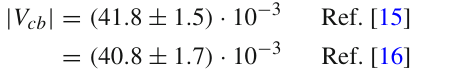
the original covariance matrices of the Belle experiments. The corre- sponding values of the reduced χ 2 -variable, χ 2 /( d.o.f. ) , are also shown